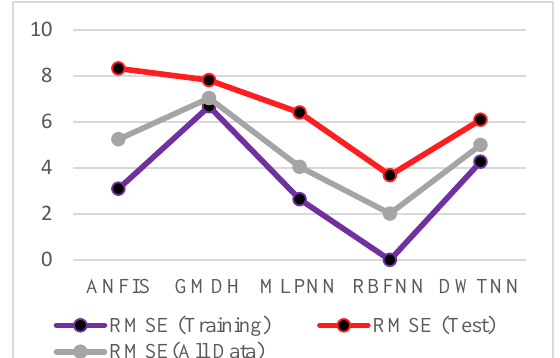
Fig. 17. RMSE values for training and test sets.